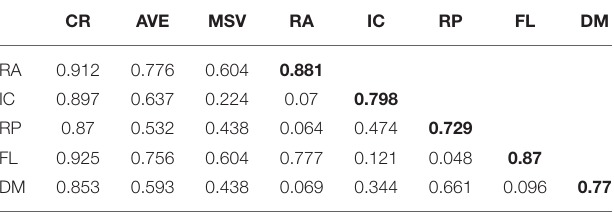
TABLE 8 | Discriminant validity.